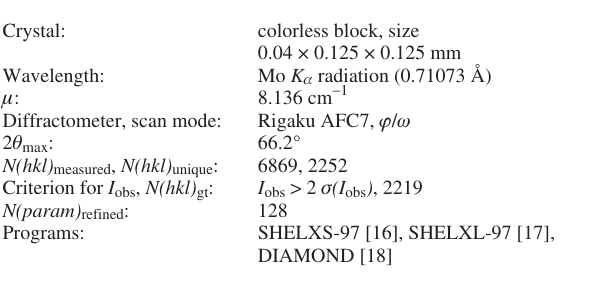
Table 1. Data collection and